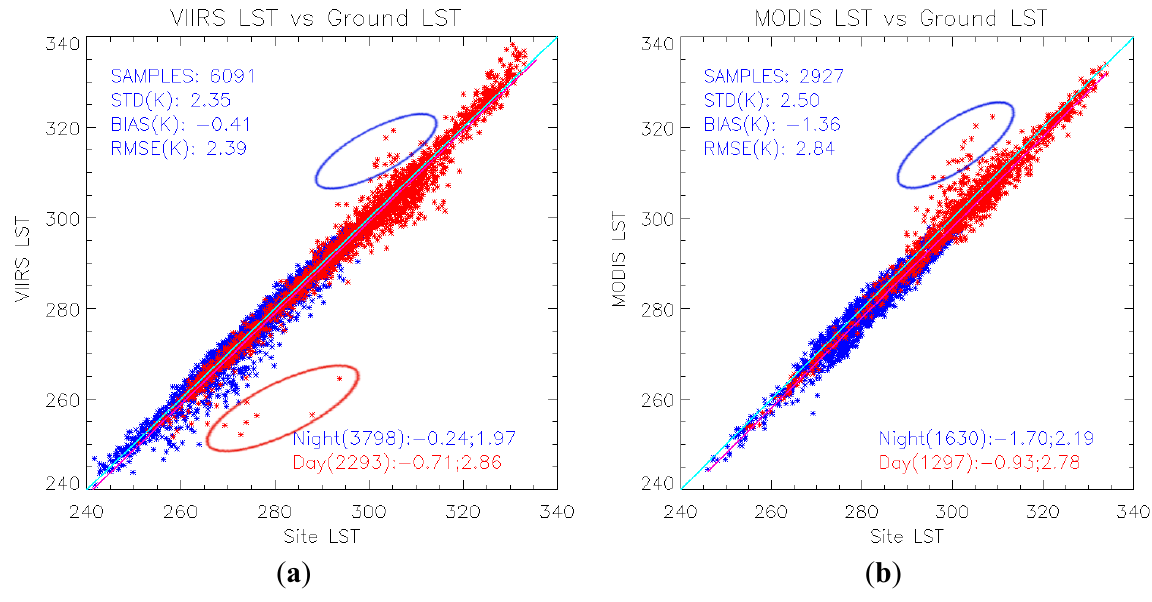
Figure 2. Scatter plots of the VIIRS LSTs ( a ) and MODIS LSTs ( b ) against the SURFRAD LSTs compared in the period from February 2012 to April 2015. Overall accuracy and precision of the satellite LSTs referring the SURFRAD LSTs are noted, as well as the daytime and nighttime cases. Some VIIRS LST plots are circled as suspicious cloud contaminated plots (red).